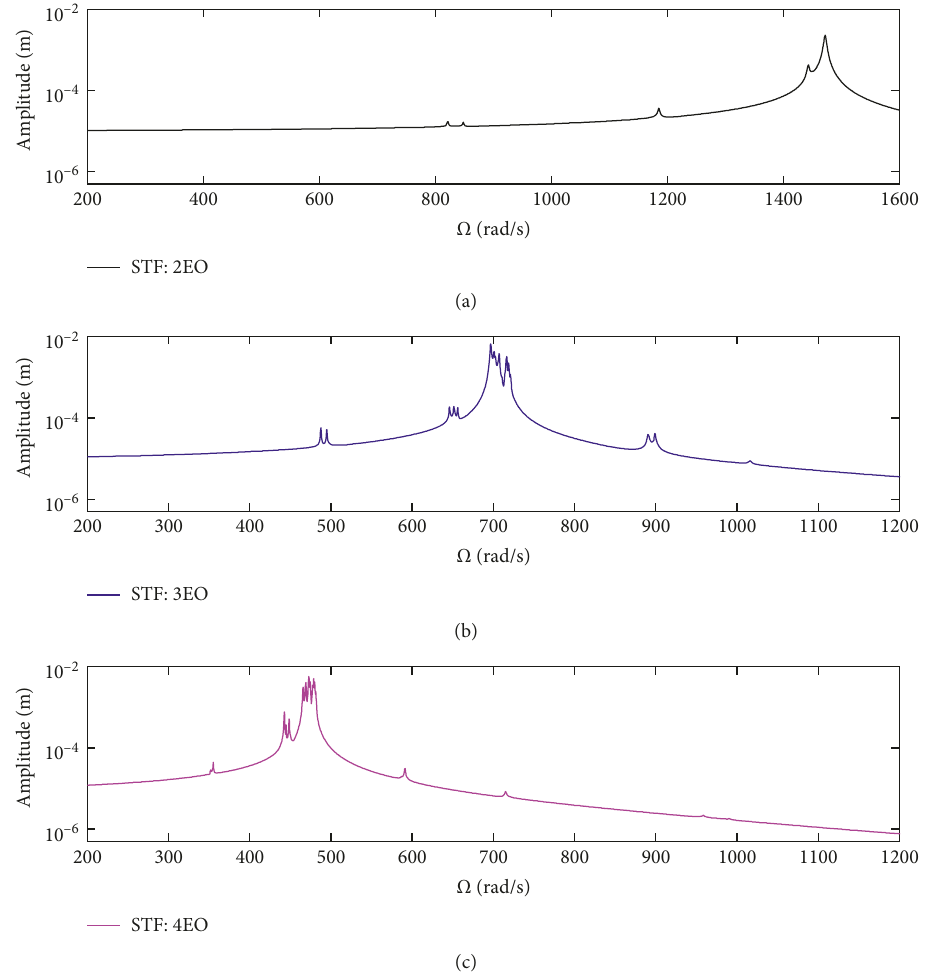
Figure 6: Forced response of case STF of mistuned bladed disk versus rotating speed excited by backward traveling wave excitations of (a) 2EO, (b) 3EO, and (c)